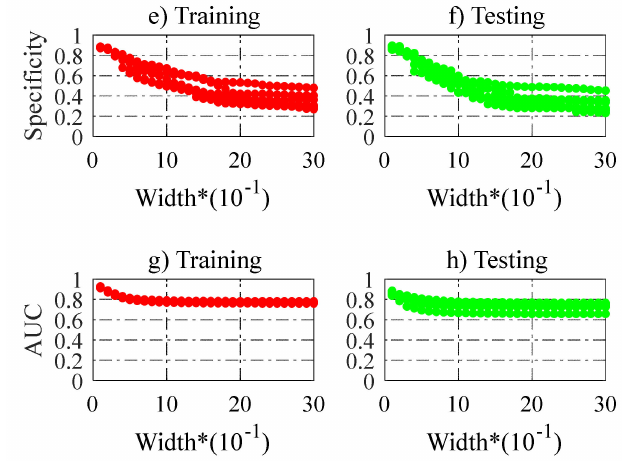
Figure 13. Performance of 210 NBs models for classifying failure modes.